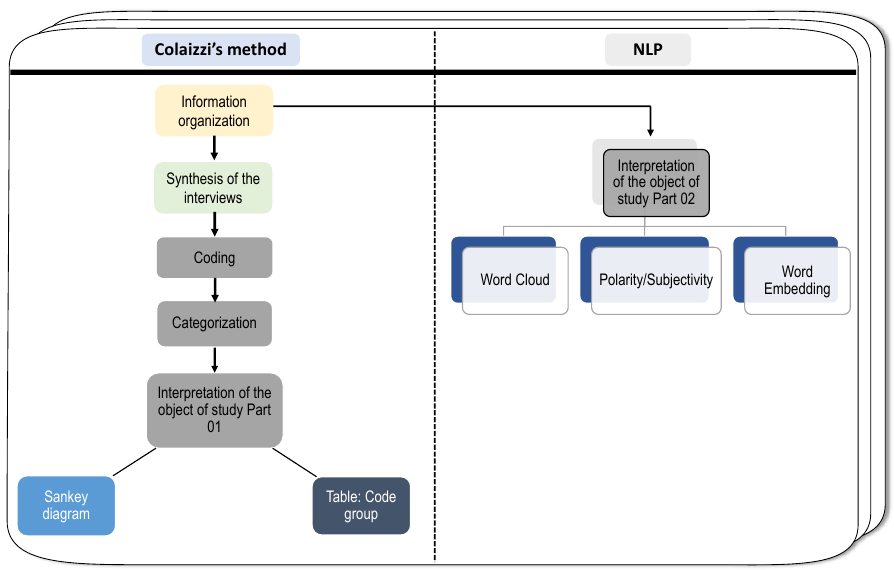
diagram Figure 2. Research